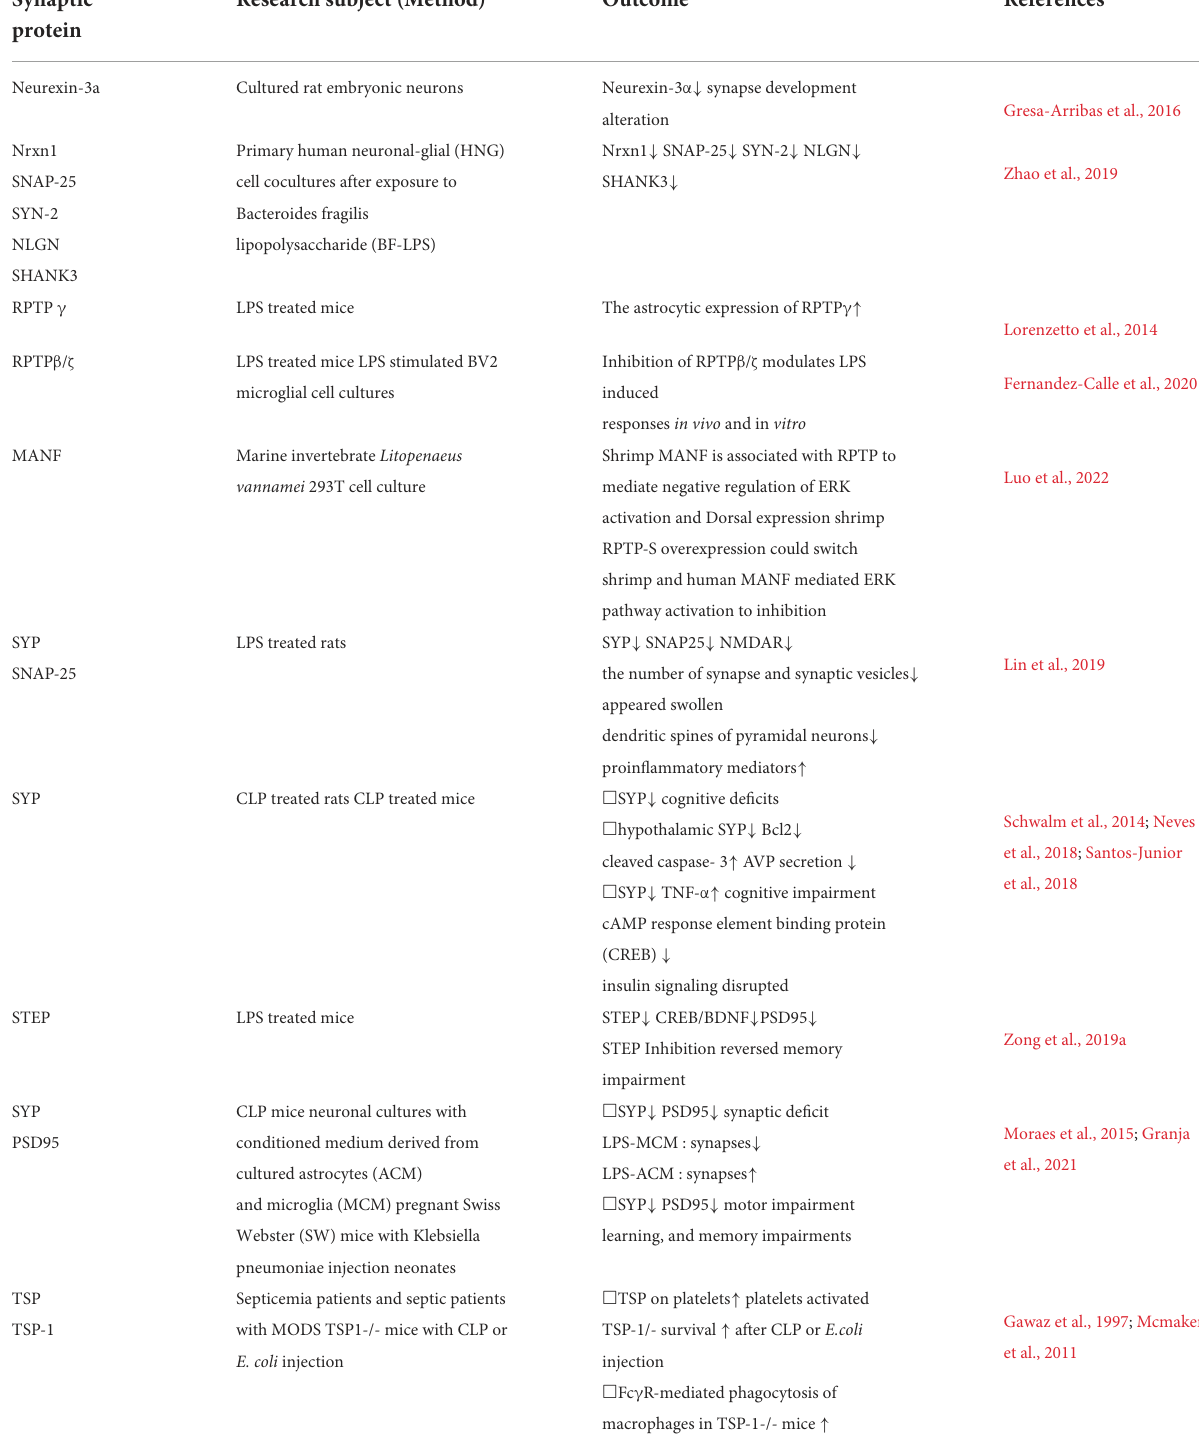
TABLE 1 Summary of synaptic